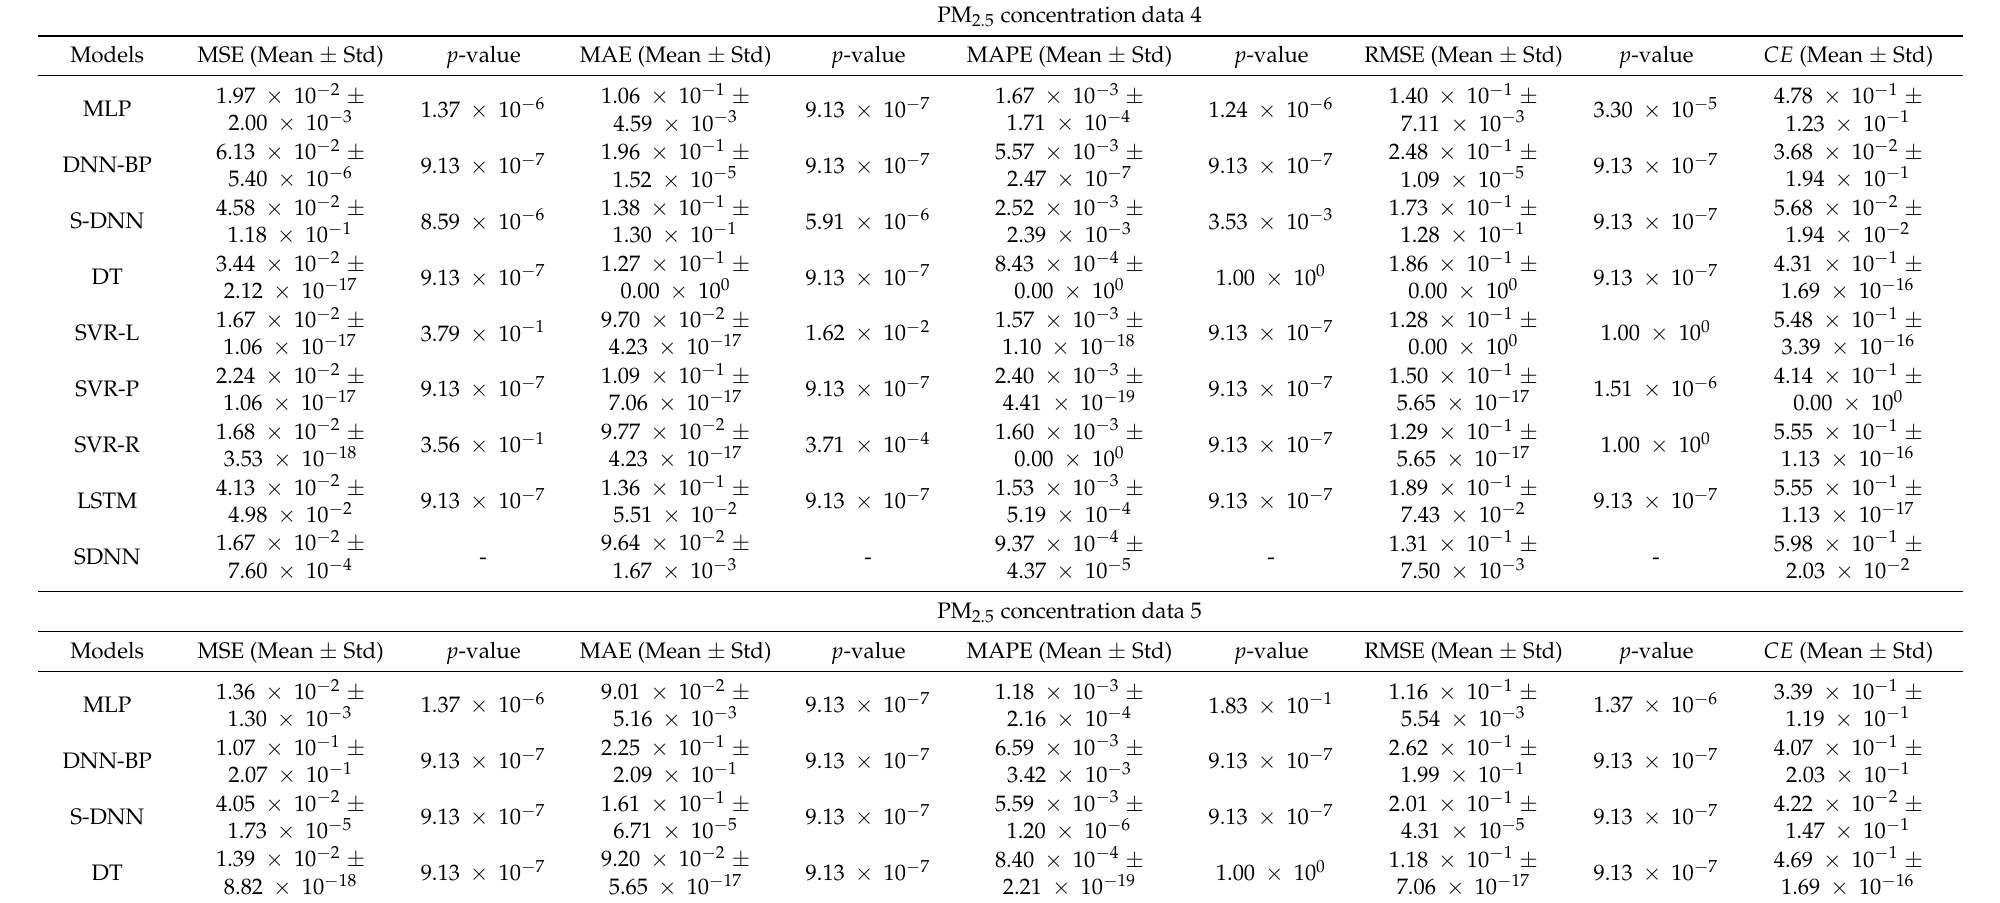
Table 9. Prediction performances of all the models for PM 2.5 concentration time series datasets